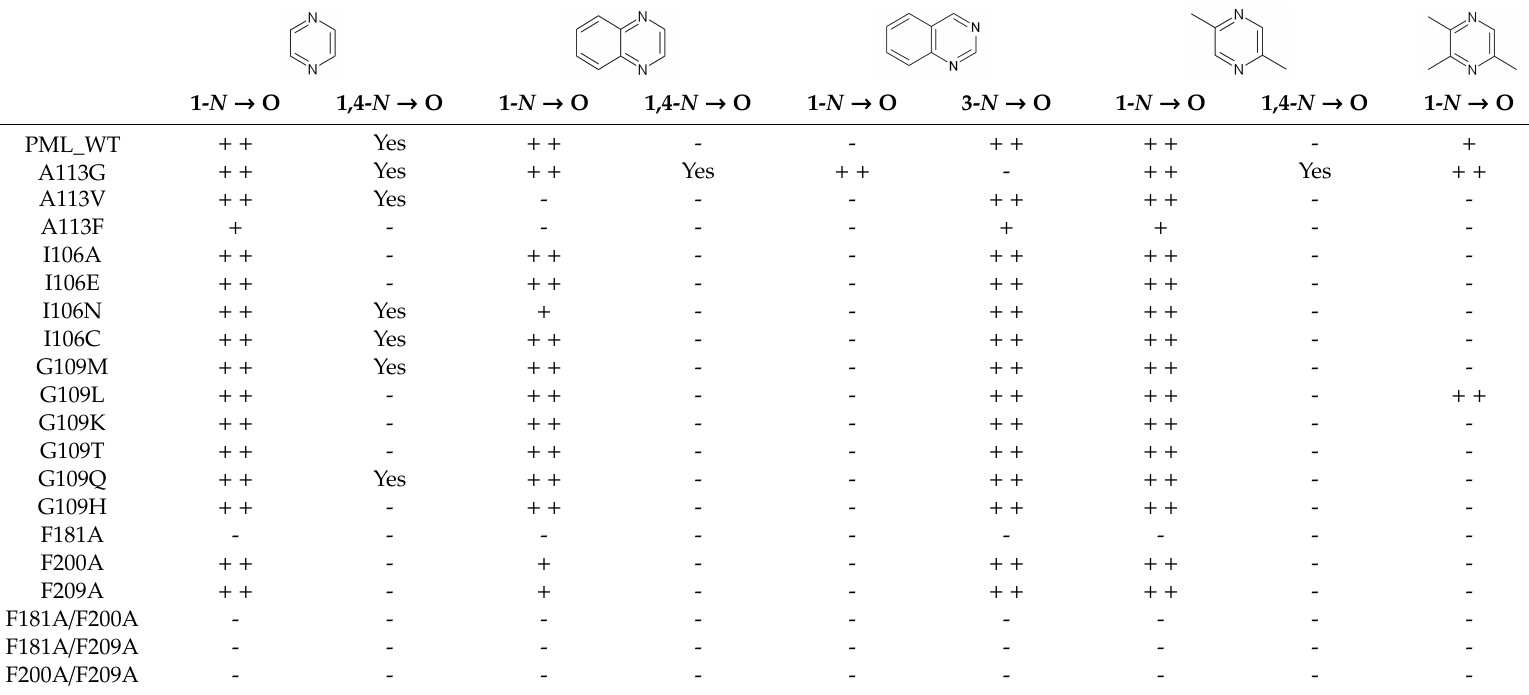
Table 1. N -oxidation capabilities of PML mutants. Mono- N -oxide conversion * is calculated based on the consumption of the substrate. High degree of conversion ( > 70%) is labeled by ‘ + + ’; conversion below 10% is depicted by ‘ + ’ sign; transformations without traceable product indicated by ‘-‘.The ability to form a corresponding di- N -oxide is marked as